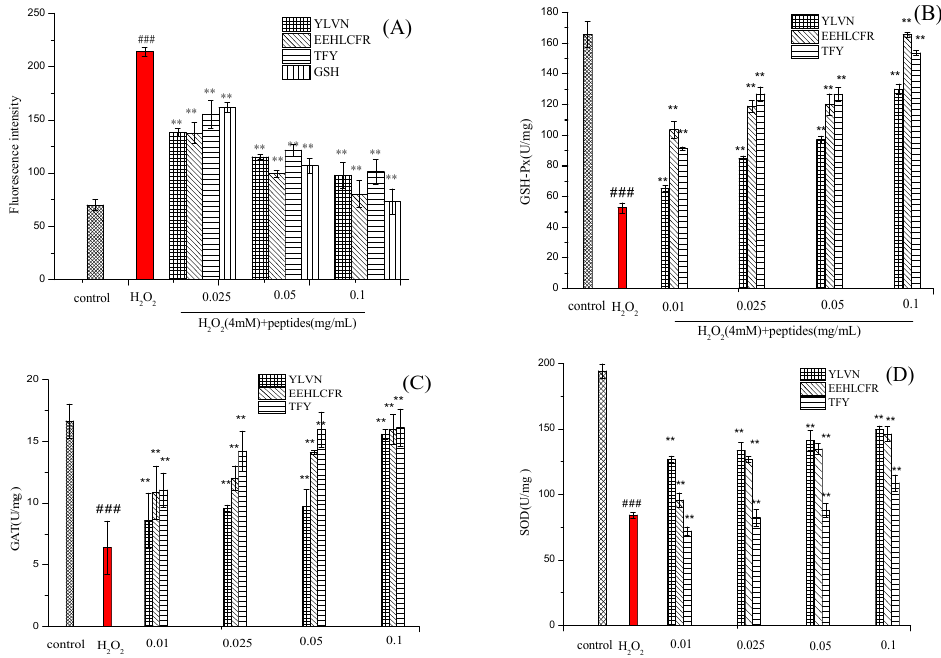
Figure 8. Effects of different peptide concentration treatments on H 2 O 2 -stressed cells. The ROS levels ( A ), GSH-Px ( B ), CAT ( C ) and SOD ( D ). ### p < 0.001 versus the control group; ** p < 0.01 versus the H 2 O 2 -induced group.